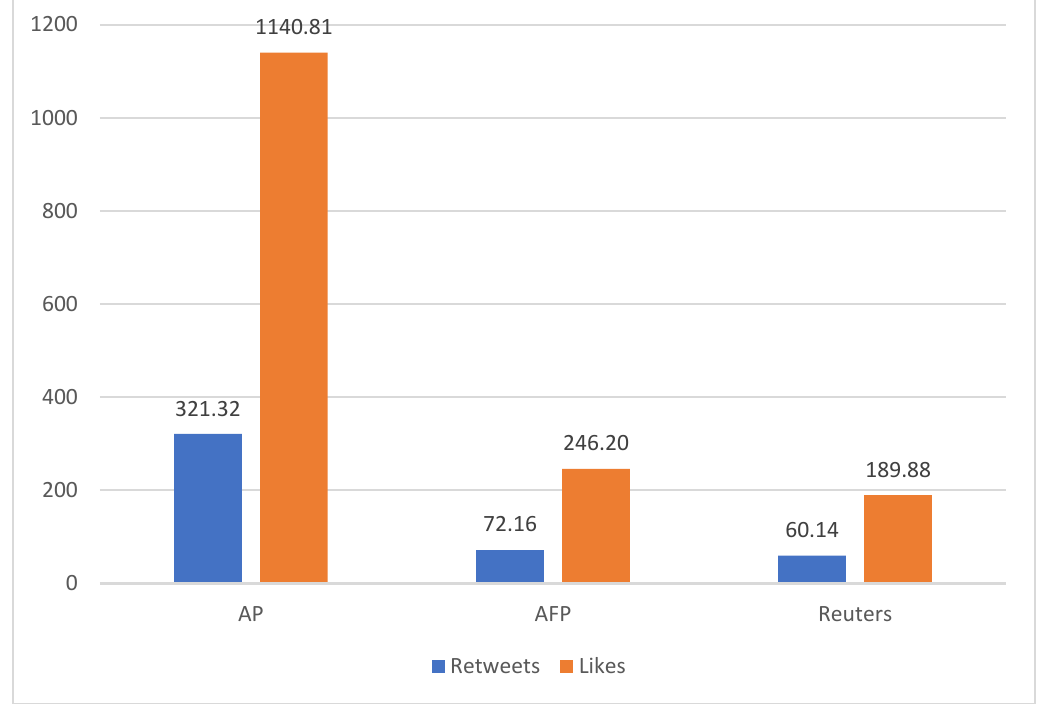
Figure 1. The mean number of retweets and likes in the three news agencies’ Twitter accounts. The median number of retweets was highest for AP’s Twitter account (Mdn = 112), followed by AFP (Mdn = 39), and Reuters (Mdn = 38). The median number of likes was highest for AP’s Twitter account (Mdn = 292), followed by Reuters (Mdn = 101) and AFP (Mdn = 57). See Figure 2 for the complete results.